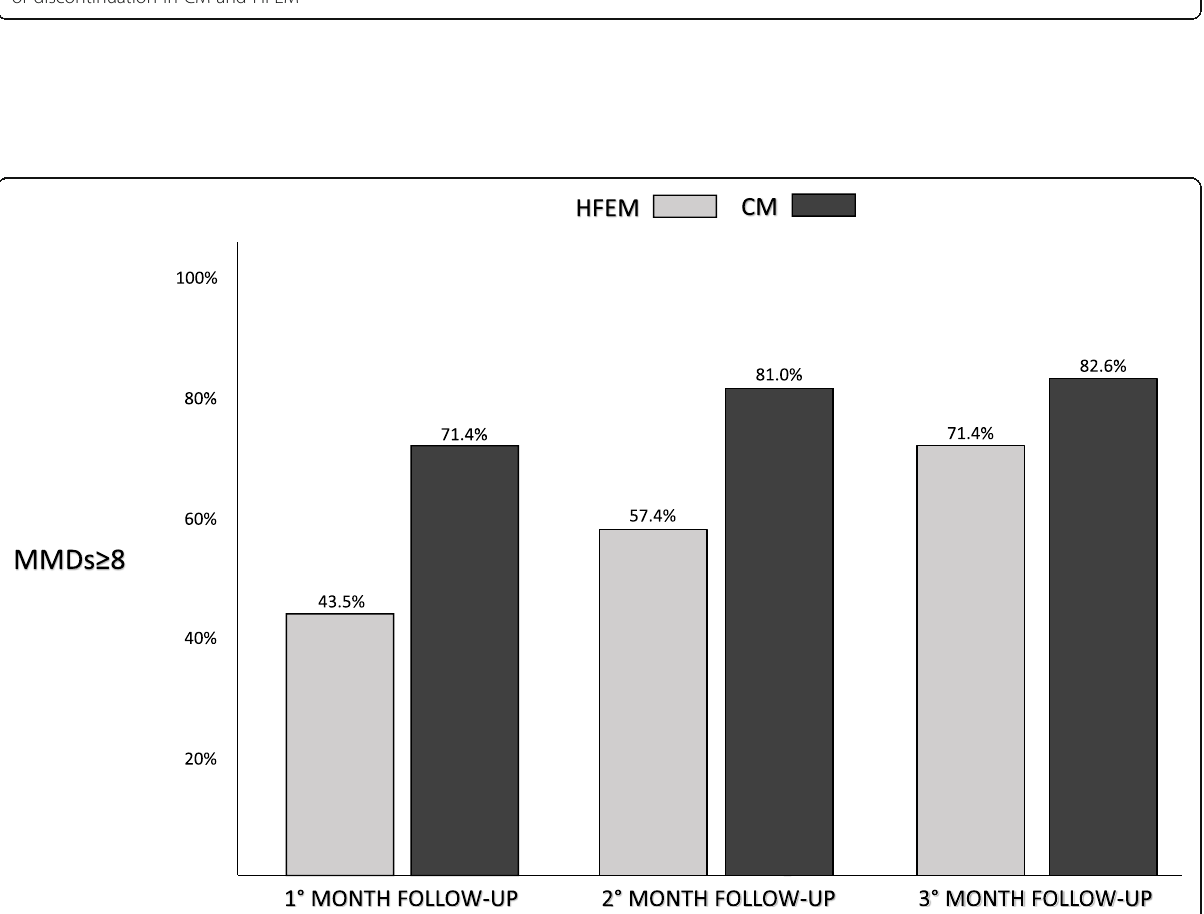
Fig. 1 The frequencies of patients with ≥ 50% response rate at the last month of therapy with mAbs anti-CGRP pathway and at the three-months of discontinuation in CM and HFEM